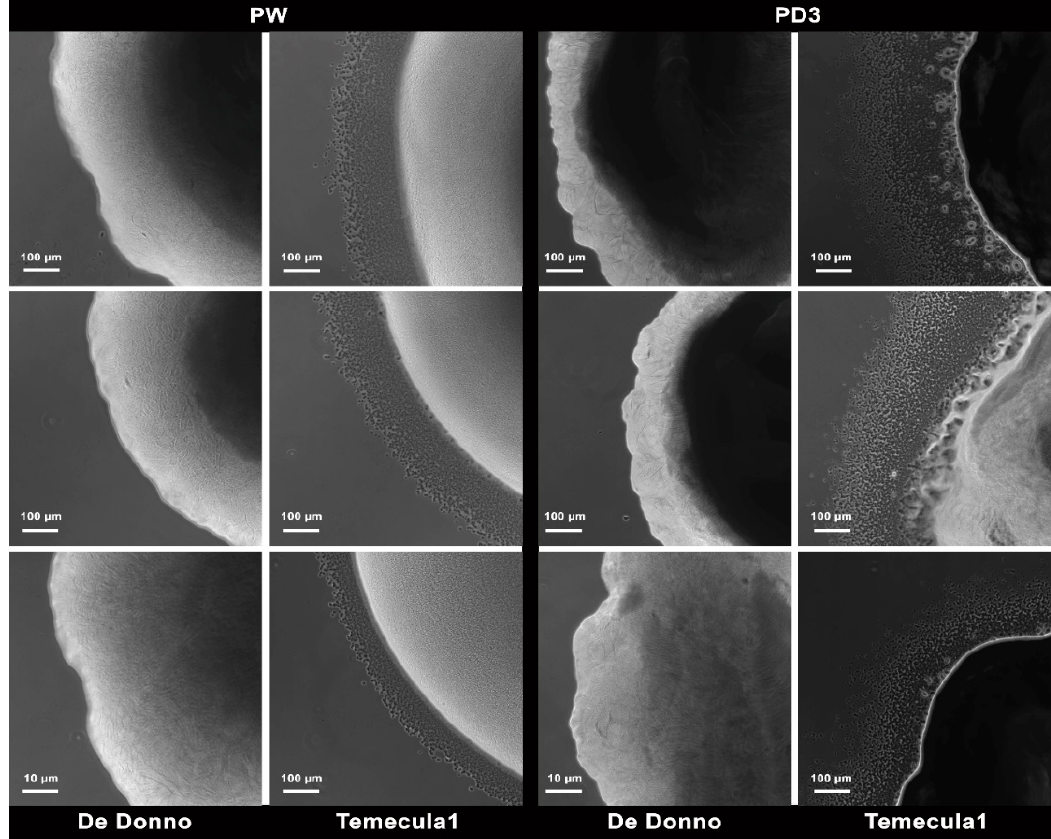
Figure 4. Twitching motility of X. fastidiosa strains Temecula1 and De Donno used in this study, assessed by measuring the fringe width of the colonies spotted on PW ( left ) or PD3 ( right ) plates 48 h post-inoculation. Measurements included three biological replicates with at least five technical replicates each.